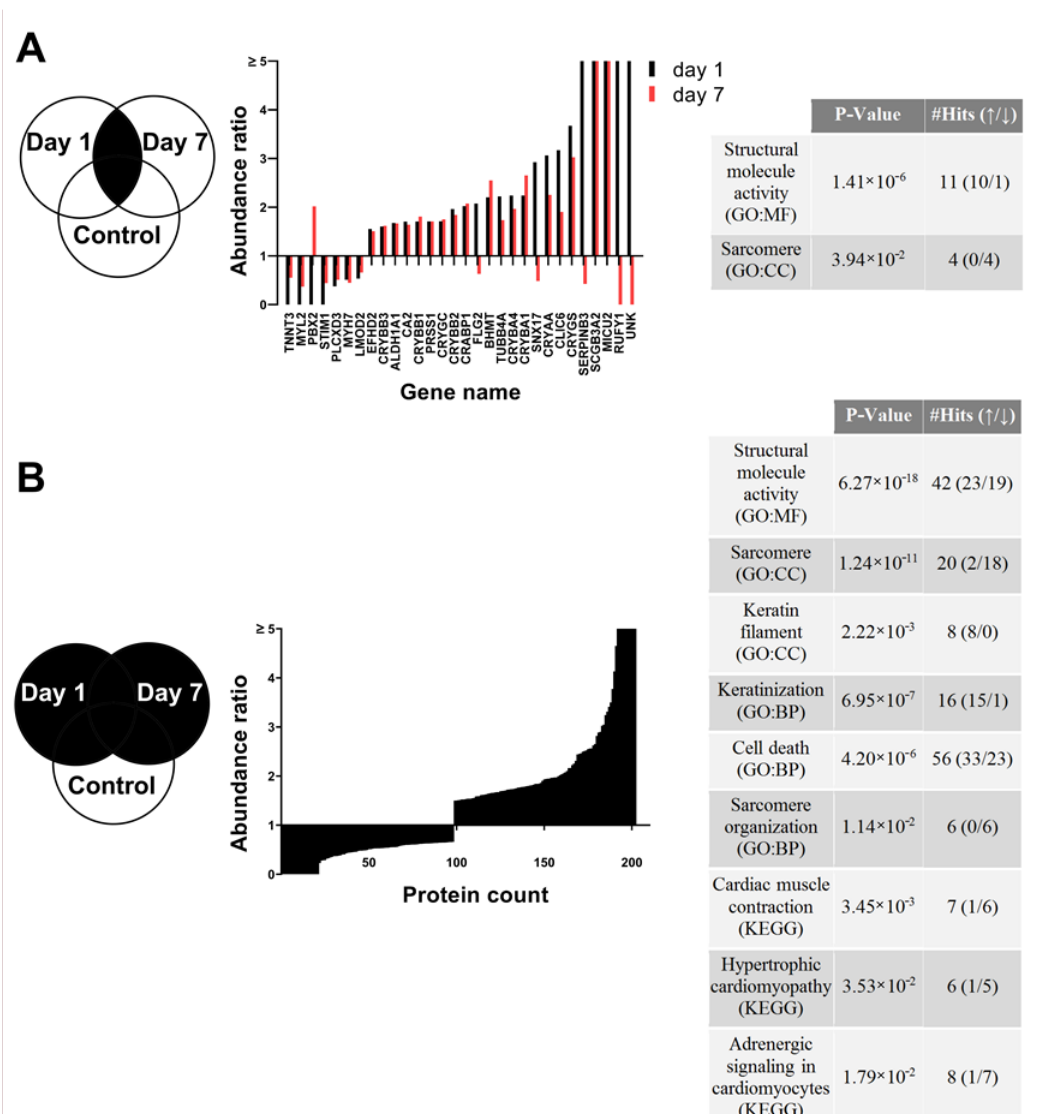
Figure 9. Robust processes of the proteome change induced by 2 Gy X-ray irradiation in hPSC-CMC. ( A ) Abundance ratios of the 30 shared and significantly deregulated (1.5 fold; adj. p value ≤ 0.05) proteins 1 day and 7 days after irradiation and associated functional analysis. ( B ) The abundance ratios of all 202 proteins significantly deregulated 1 day and 7 days after irradiation and associated functional